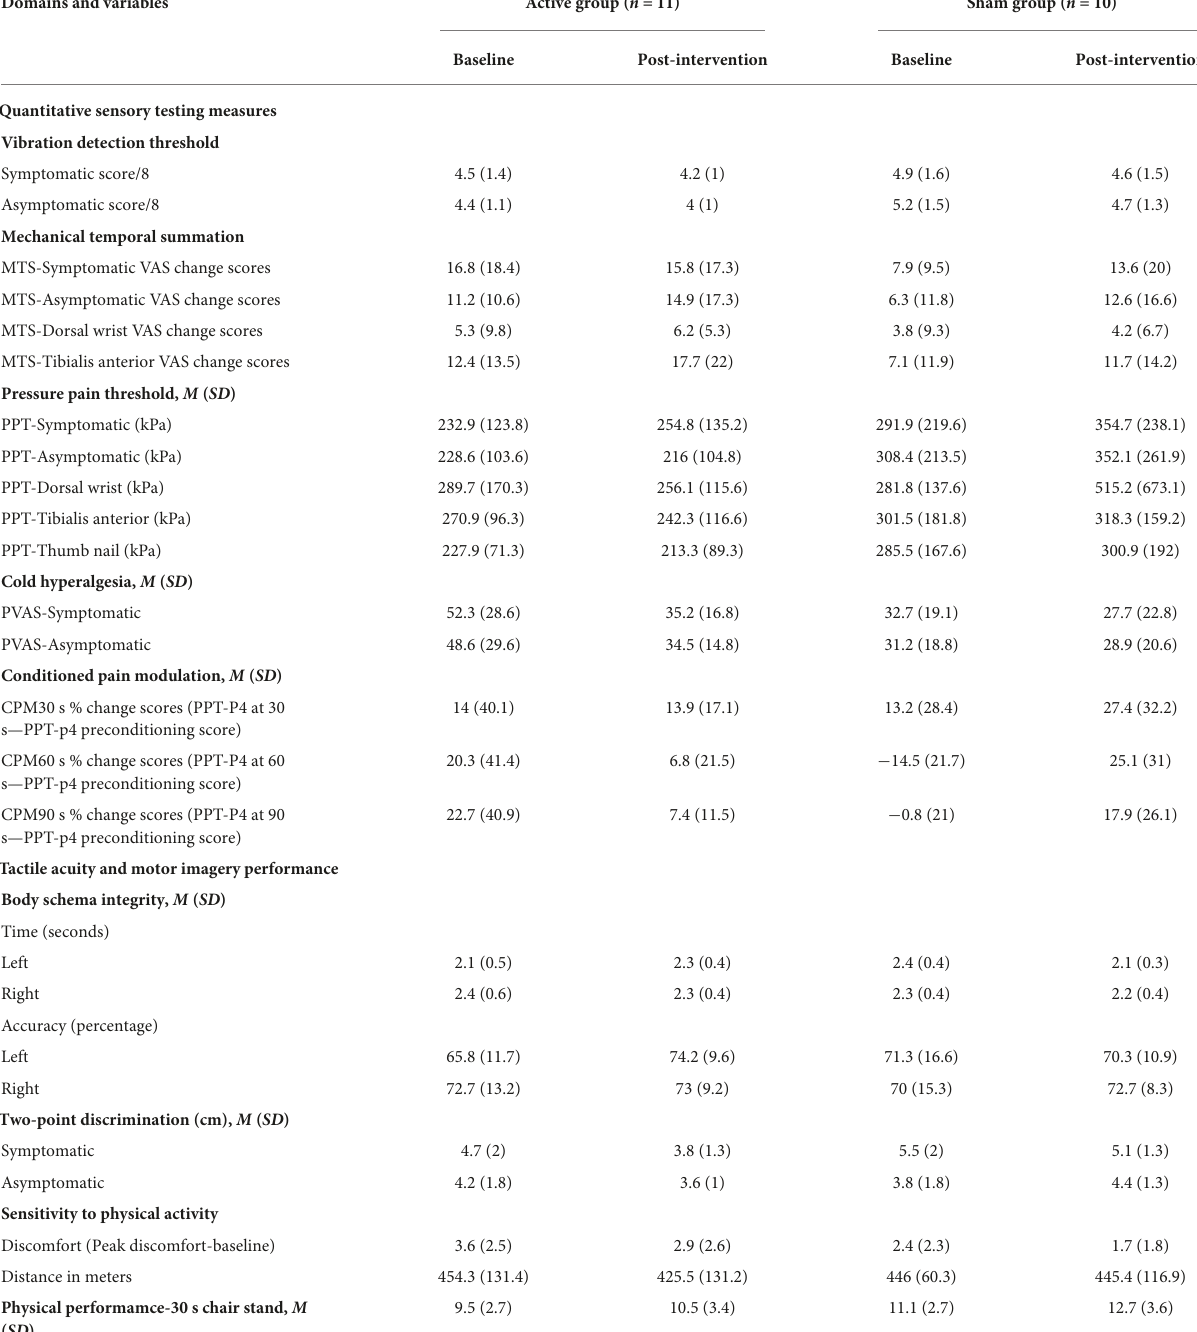
TABLE 6 Experimental pain measures and physical performance